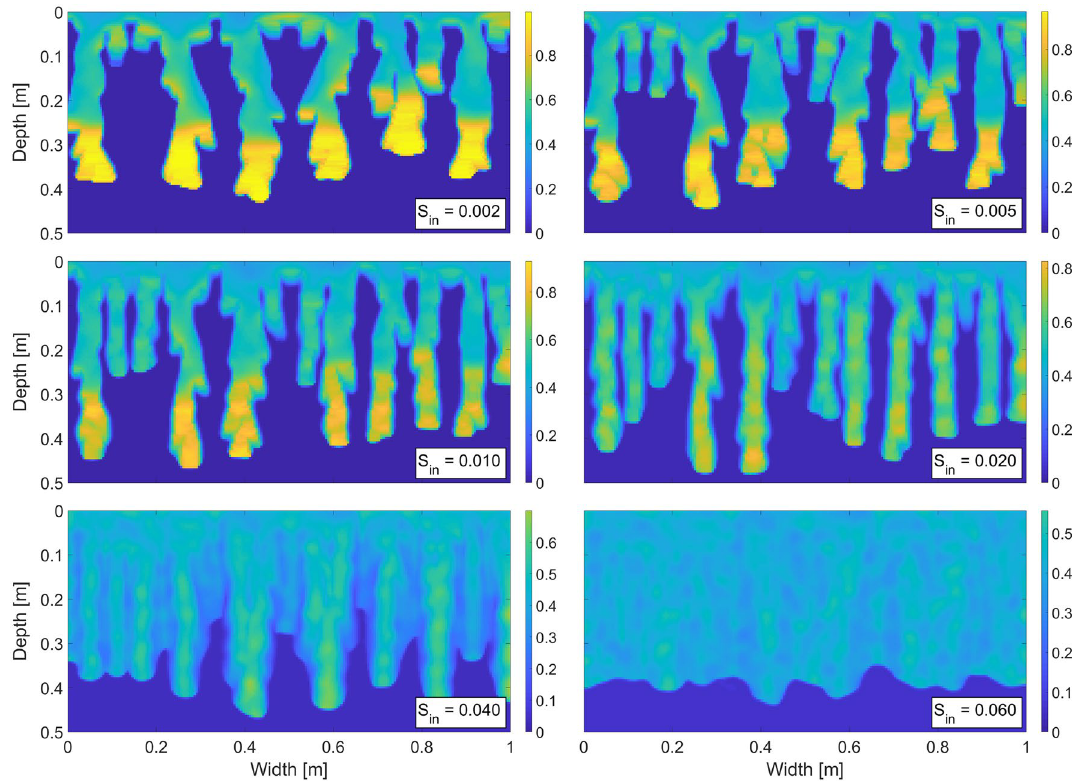
Figure 6. Snapshot of the saturation field at 10 mins for six different values of the initial saturation. See the Supplementary Information for full videos. Saturation values are colour-coded according to the colour bar on the